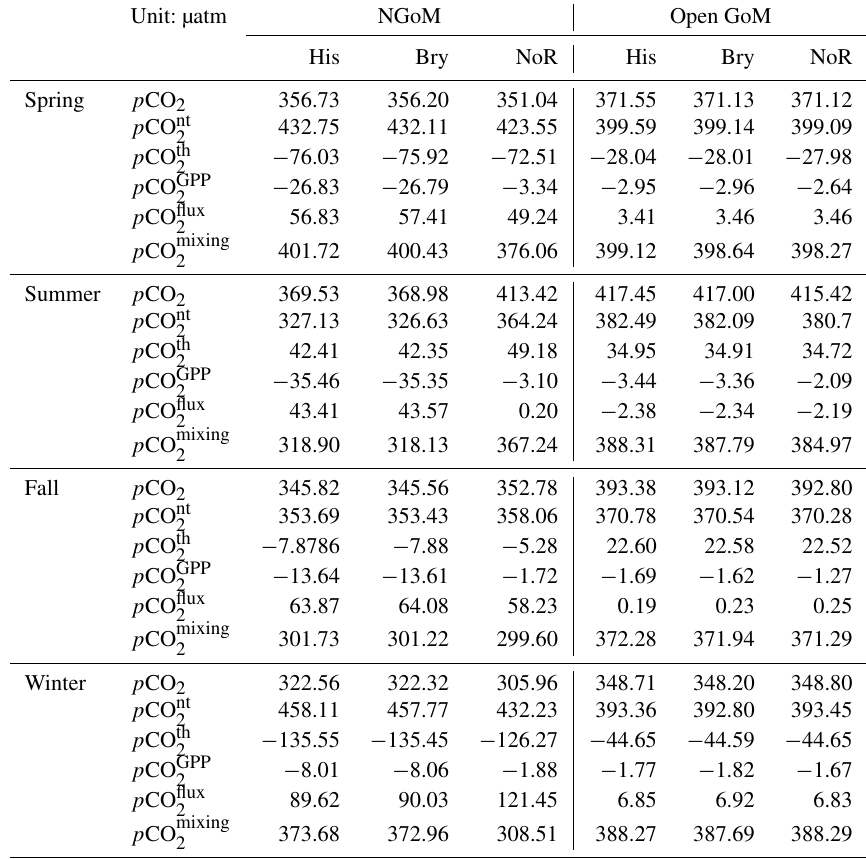
Table 1. Sea surface p CO 2 decomposition among experiments. Unit: µatm NGoM